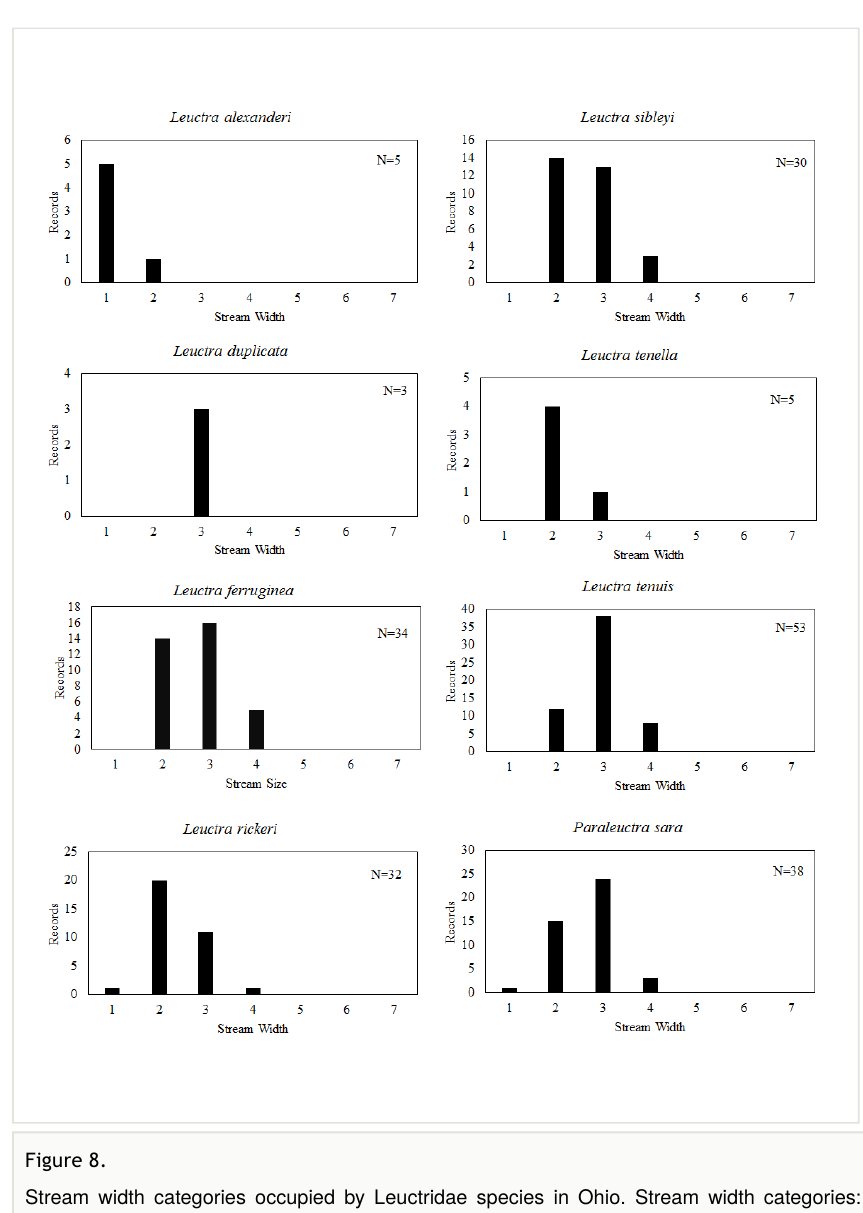
Figure 8. Stream width categories occupied by Leuctridae species in Ohio. Stream width categories: 1=seep, 2=1-2 m, 3=3-10 m, 4=11=30 m, 5=31-60 m, 6=>60 m, 7=Lake